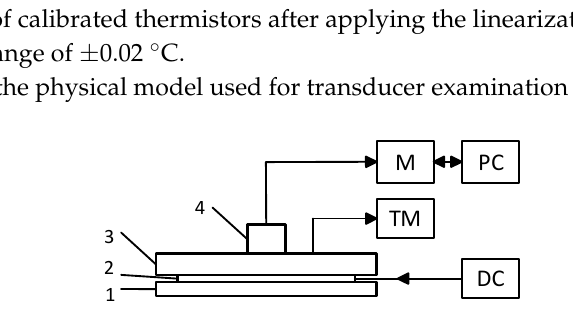
Figure 3. Structure diagram of the experiment. 1—cooler; 2—Peltier element; 3—polyethylene plate